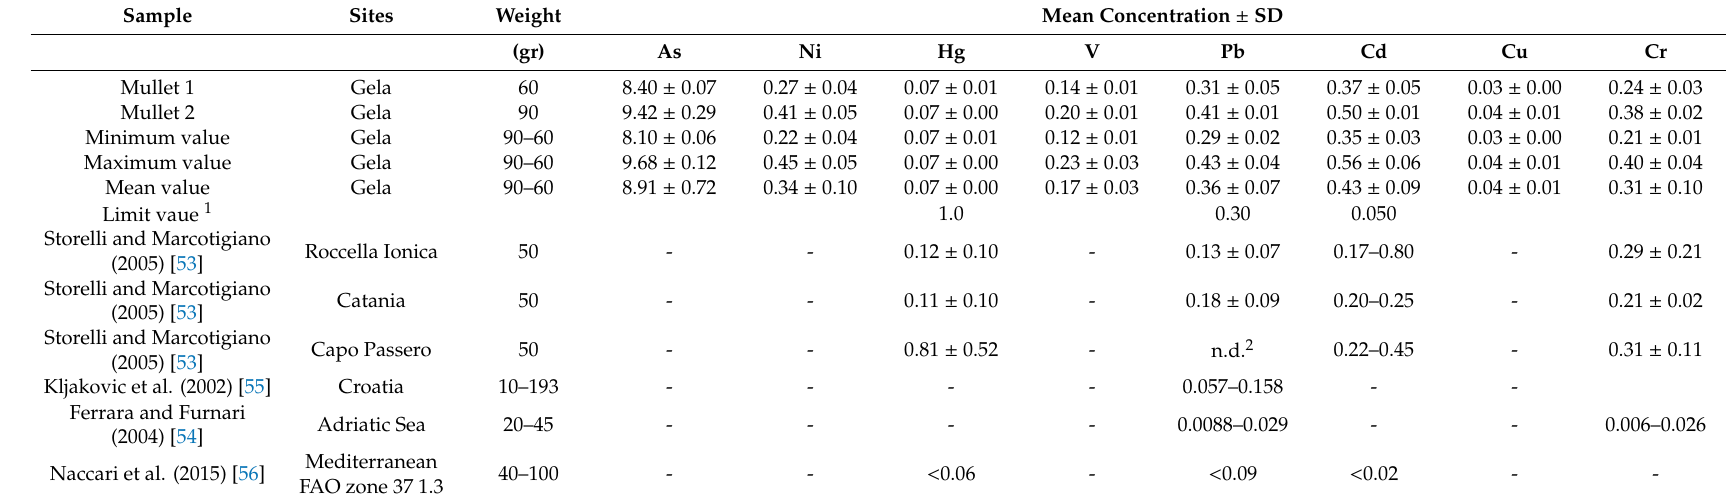
Table 6. Concentration (mg kg − 1 wet weight, mean ± SD) of potentially toxic elements in mullets ( Mullus barbatus ) samples from Gela and compared with samples from di ff erent Mediterranean